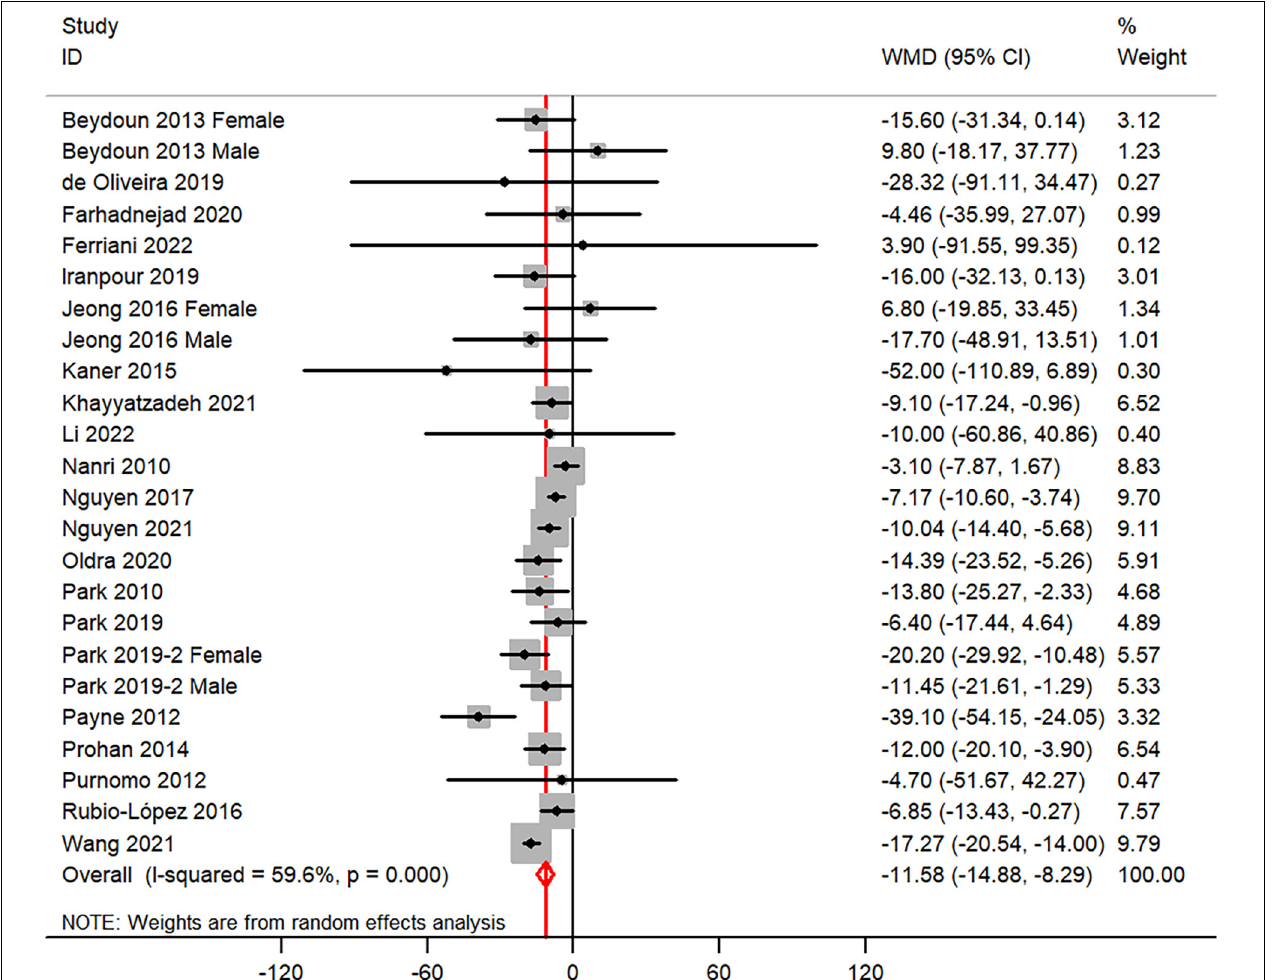
FIGURE 3 | Forest plot of meta-analysis: WMD of dietary vitamin C intake for depression versus control subjects.